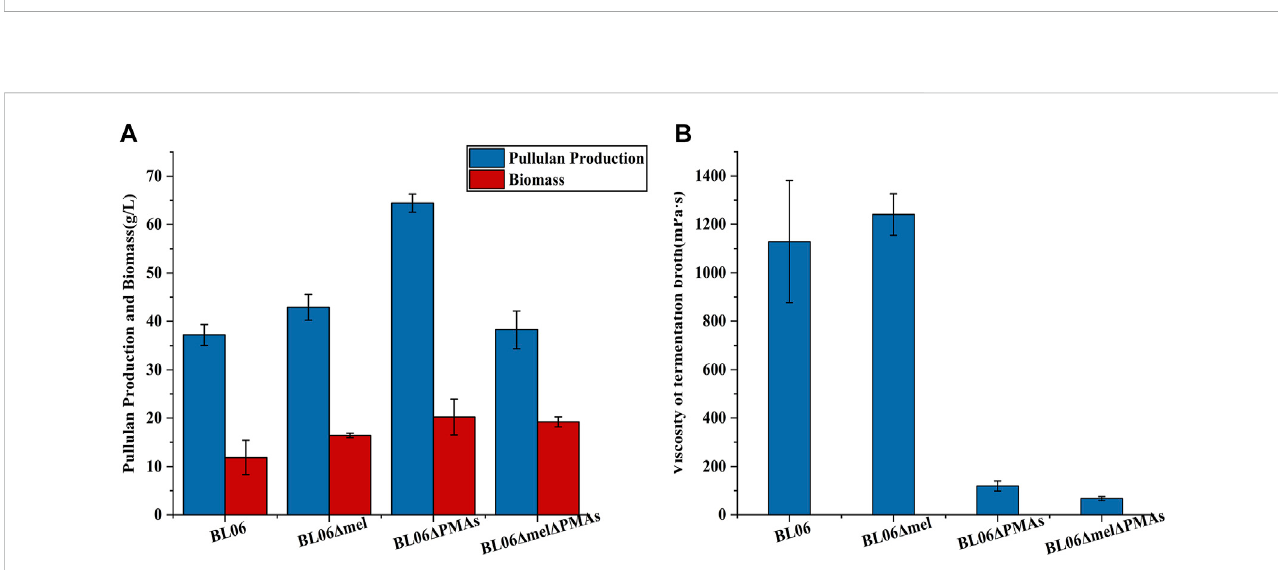
FIGURE 4 Pullulan production and viscosity of fermentation broth of the engineered strains. (A) Pullulan production and biomass of the engineered strains after 120 hfermentation; (B) Viscosityoffermentationbrothoftheengineeredstrainsafter120 hfermentation. Allvaluesareexpressedasthemeans±SDs( n =3).